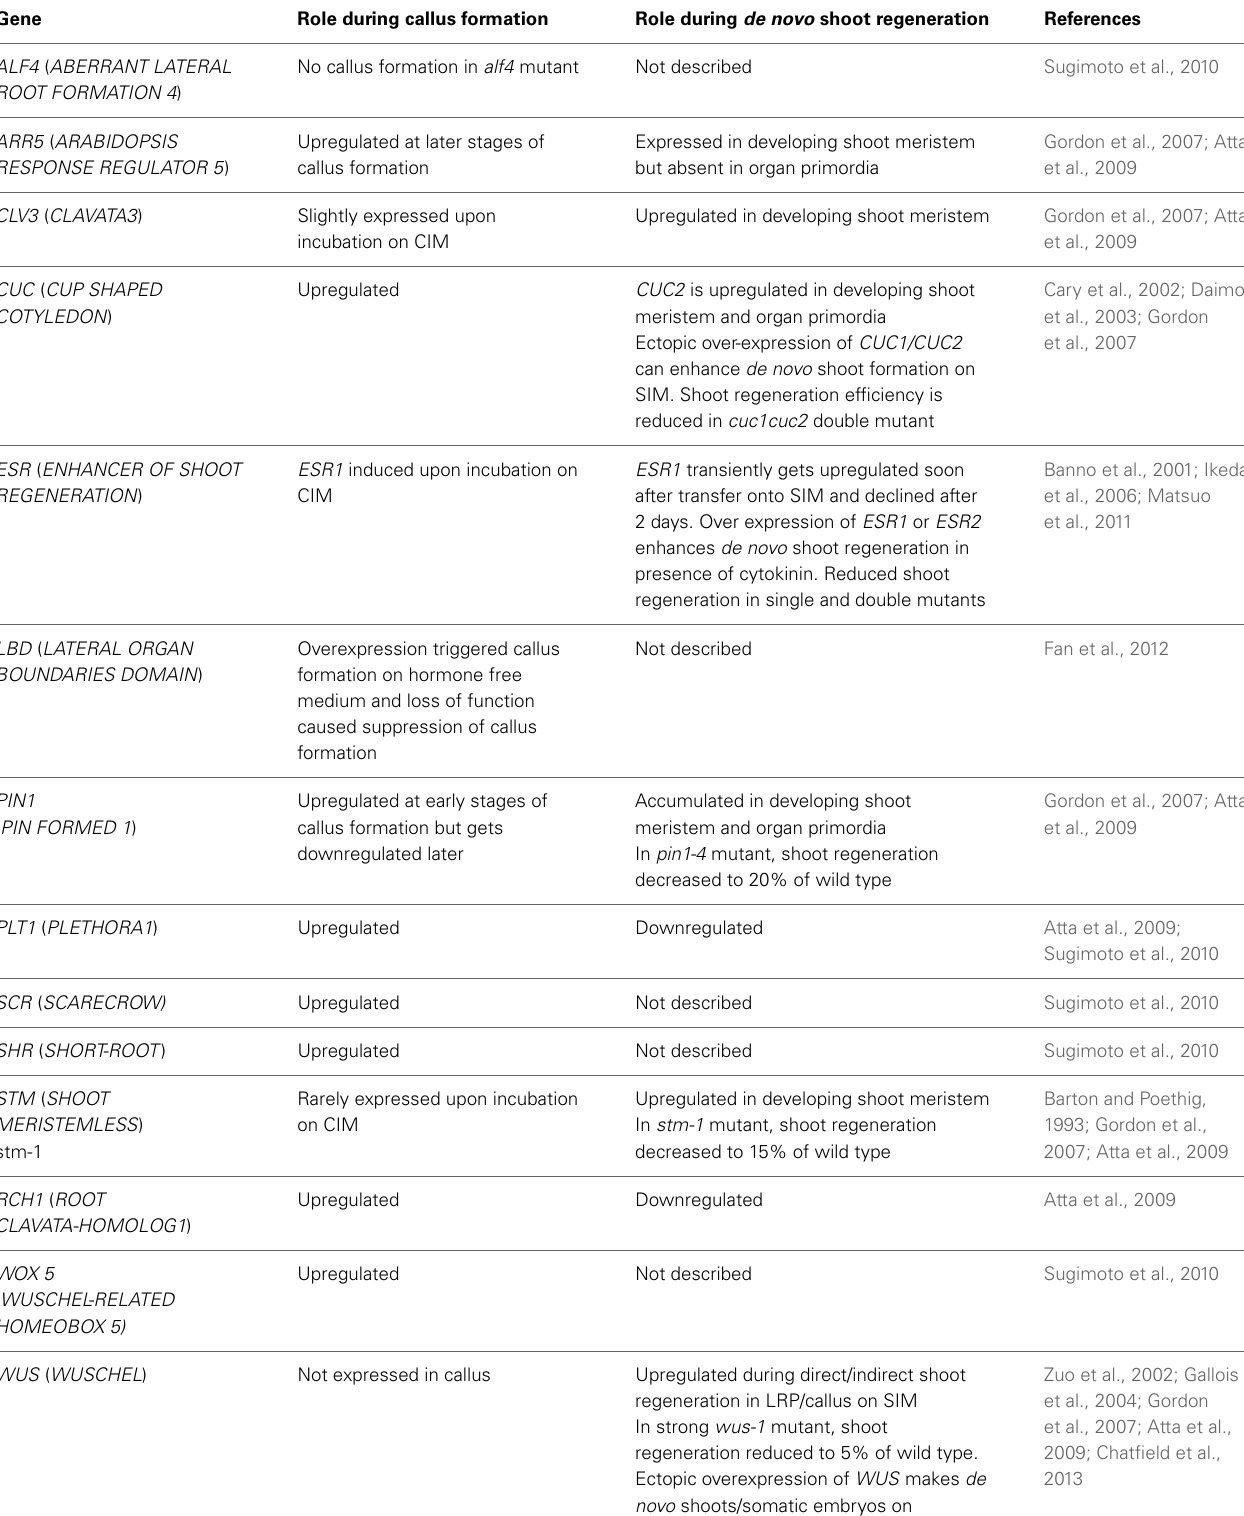
Table 1 | List of key genes involved in de novo organ regeneration